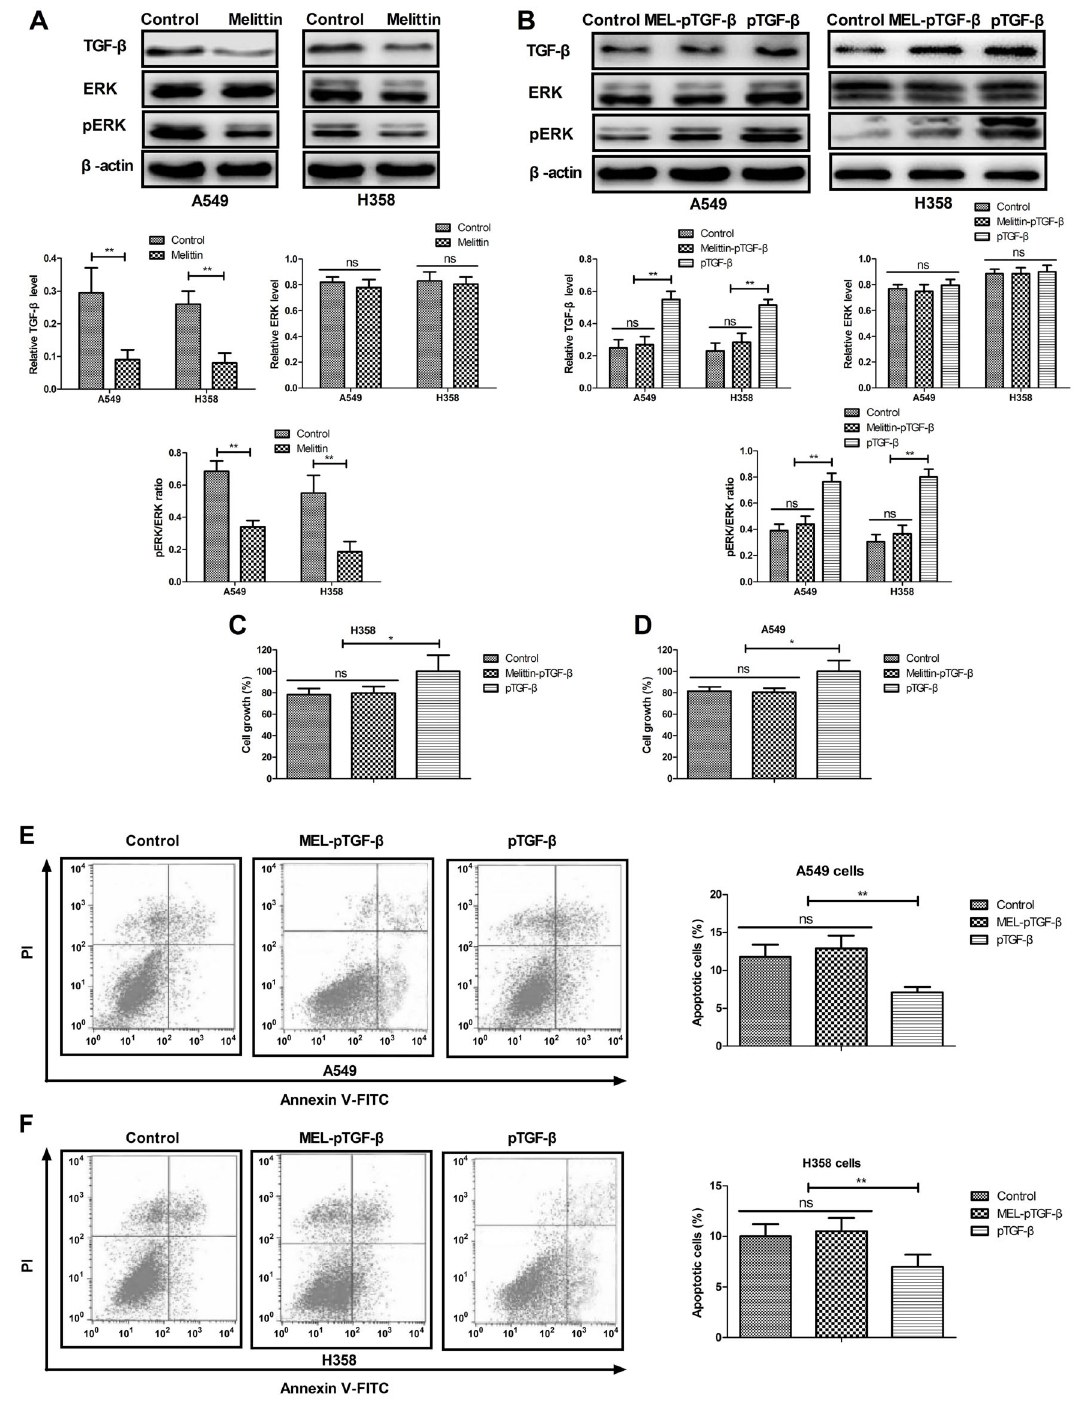
Figure 3. Melittin inhibited growth of non-small-cell lung cancer cells (A549 and H358) via tumor growth factor (TGF)- b -mediated ERK signaling pathway. A , Melittin (2.0 m g/mL) downregulated TGF- b , ERK, and pERK expression. B , TGF- b overexpression (pTGF- b ) canceled melittin-inhibited TGF- b expression and phosphorylation levels of ERK. C and D , TGF- b overexpression (pTGF- b ) abolished melittin-inhibited (MEL-pTGF- b ) growth. E and F , Effects of TGF- b overexpression (pTGF- b ) on melittin-induced apoptosis. *P o 0.05, **P o 0.01 (Student ’ s t -test and ANOVA). ns: not signi fi